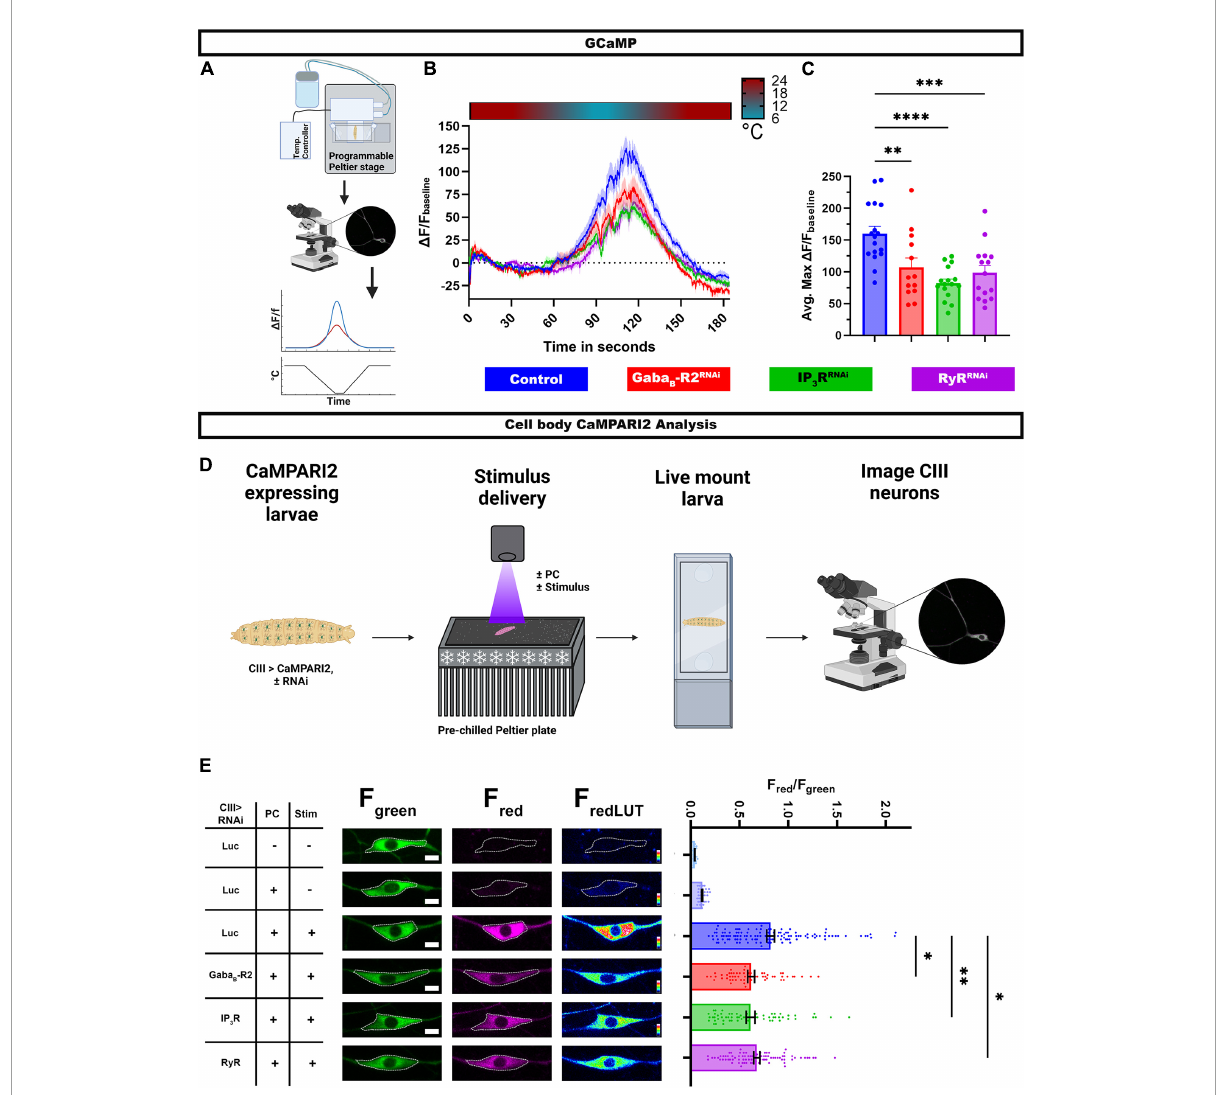
FIGURE4 G protein coupled receptor (GPCR) and CICR signaling are required for cold-evoked Ca 2 + dynamics. (A–C) Cold-evoked in vivo GCaMP6 imaging of CIII md neuron cell bodies. (A) Schematic of cold stimulus delivery and imaging system. (B) Plot of (cid:49) F/F baseline over time of CIII md neuron cell body (ddaF) expressing GCaMP6m and gene knockdown for GABA B -R2 , IP 3 R , or RyR compared to control ( Luc RNAi ). (C) Max (cid:49) F/F baseline for cold-evoked GCaMP response in CIII md neuron cell body. N Average = 15. Statistics: One-way ANOVA with Holm-Šídák’s for multiple comparisons. (D,E) In vivo analysis of CaMPARI2 responses to noxious cold in CIII md neurons expressing gene knockdowns for GABA B -R2 , IP 3 R , or RyR compared to control ( Luc RNAi ). (D) Graphical schematic of cold plate assay combined with photoconverting (PC) light and post hoc imaging. (E) Left: Representative images of CIII md neurons expressing CaMPARI2 and gene specific RNAi. Cell bodies are outline in dashed white line. Scale bar: 5 µ M. Right: CaMPARI2 responses of CIII md neurons (ddaA and ddaF) plotted as fluorescence ratios of F red /F green . N Average = 62. Statistics: Kruskal-Wallis with Benjamini, Krieger and Yekutieli for multiple comparisons. Significant differences indicated via asterisks, where ∗ p < 0.05, ∗∗ p < 0.01, ∗∗∗ p < 0.001, and ∗∗∗∗ p < 0.0001. Created with